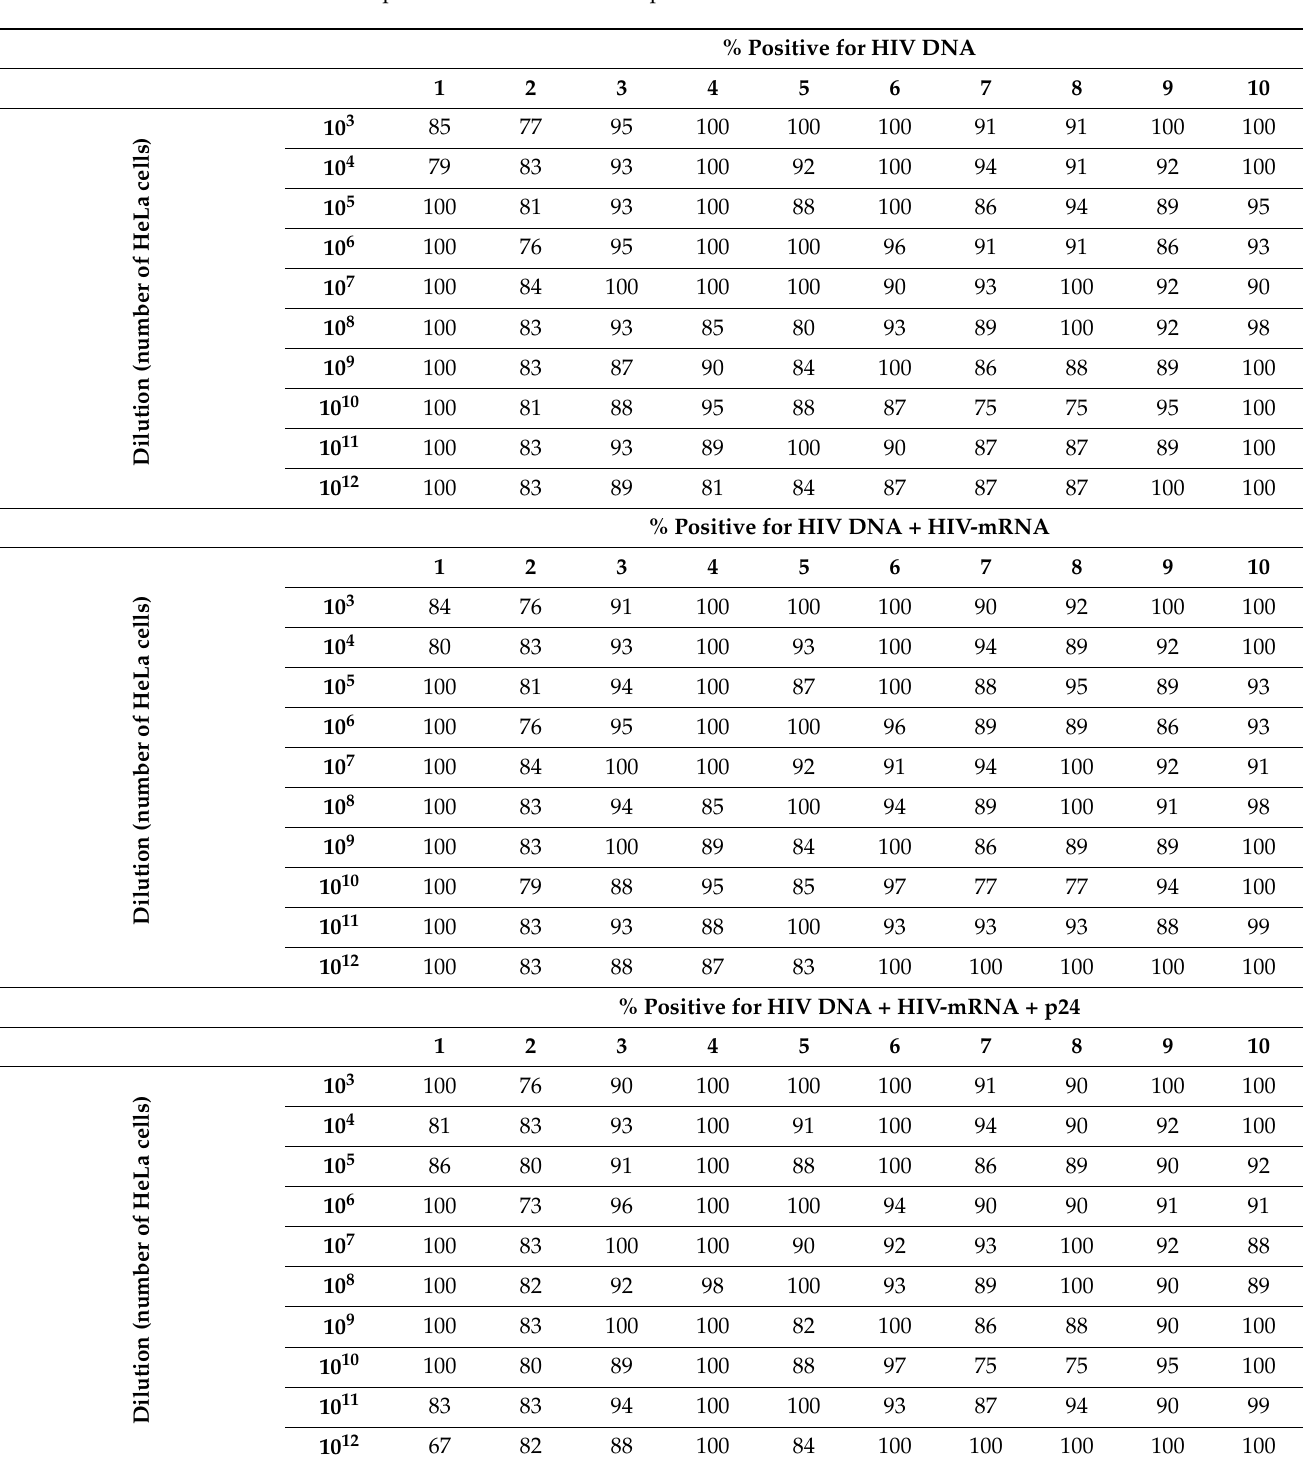
Table 5. Detection of HIV DNA, HIV-mRNA, and HIV protein in ACH-2 cells. To calculate our image system’s sensitivity to detect viral reservoirs, we diluted cells with one copy of integrated HIV DNA (ACH-2), one to ten cells into 10 3 to 10 12 HeLa cells. Then, staining for HIV DNA (top), HIV-mRNA (middle), or HIV-p24 (bottom) was performed to identify whether we could detect the diluted cells in the HeLa cells. The percentage of detection is indicated for 10 sample preparations for each dilution. Pellets of these cells were cut and analyzed by microscopy to identify the infected cells. These cells were not treated with reactivating agents such as TNF- α or SAHA. Thus, detection corresponds to the baseline viral